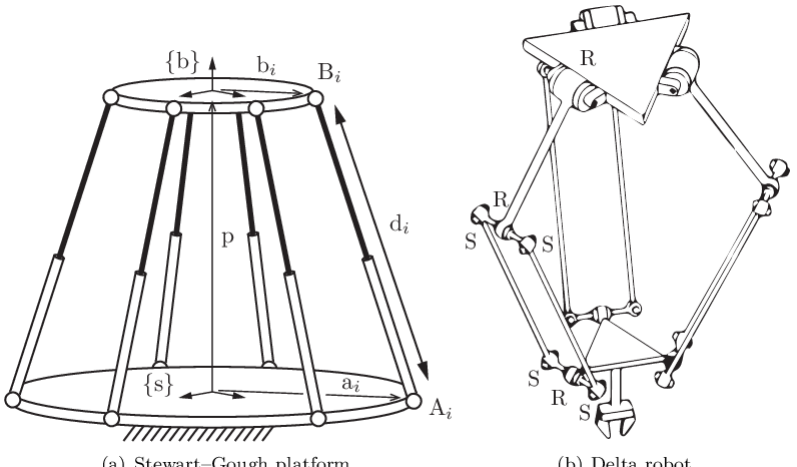
Figure 1. Popular parallel mechanisms